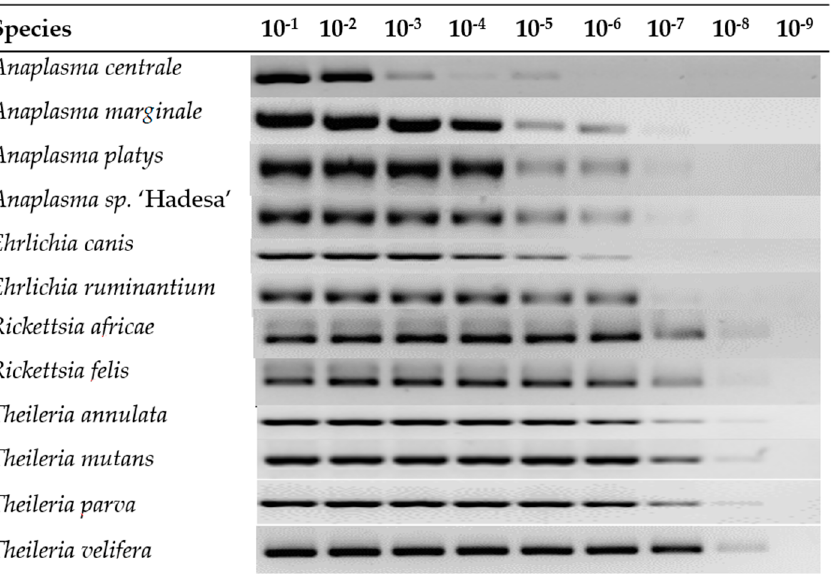
Figure 3. Serial dilution of plasmid amplicons in a 1.5% agarose gel electrophoresis. The last visible band determines the limit of detection which is the lowest dilution detectable on the agarose gel.